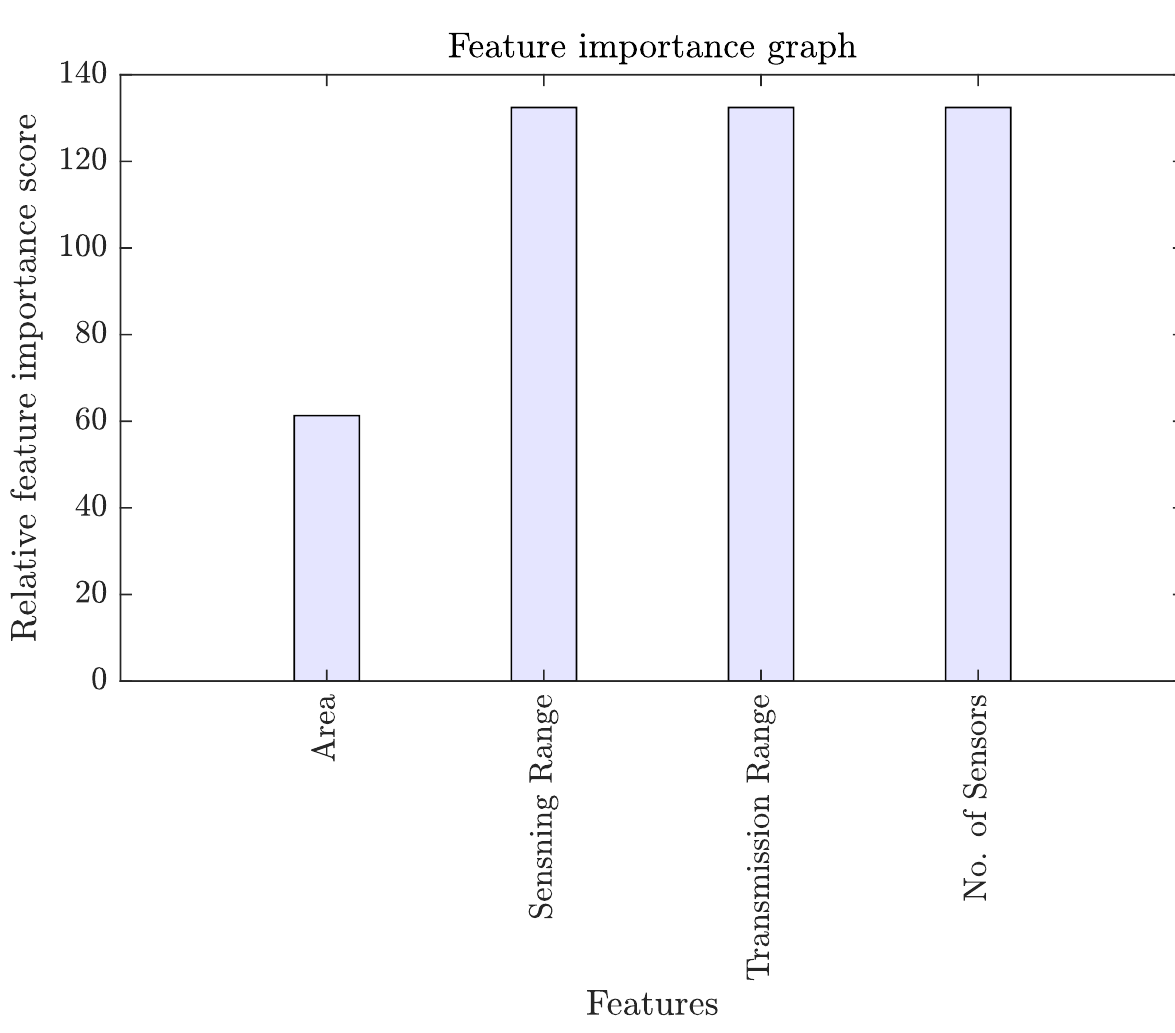
Figure 4. Bar graph illustrating each feature’s relative feature importance score estimated through regression tree ensemble